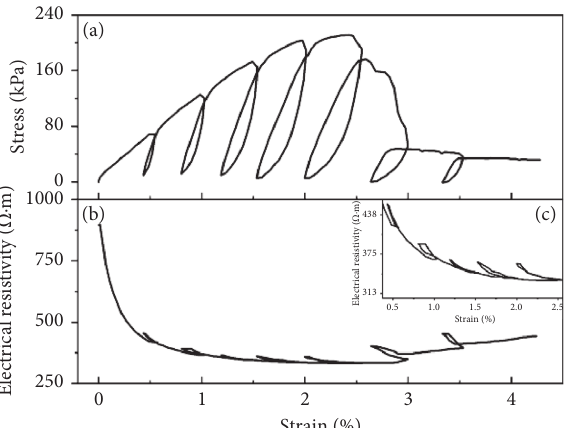
Figure 10: Strain-stress-electric resistivity curve of loess under loading and unloading conditions (Figure 10(c) is a detailed view of Figure 10(b)).